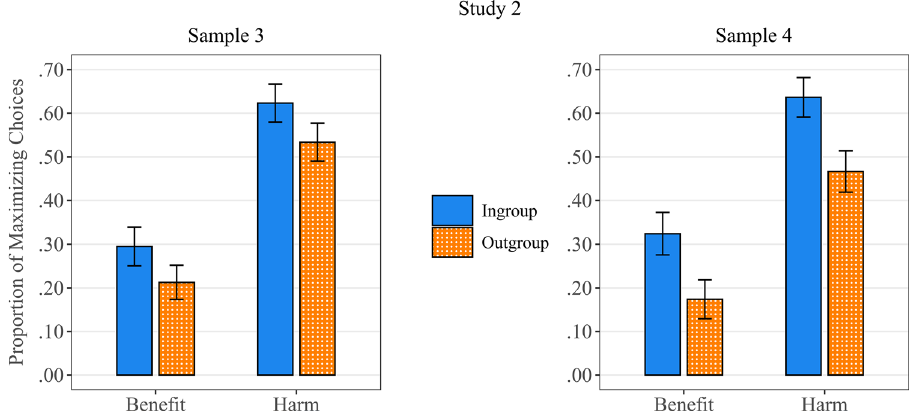
Figure 2. Proportion of outcome Maximizing choices as a function of target group (Ingroup versus Outgroup) and type of outcome (Benefit versus Harm).